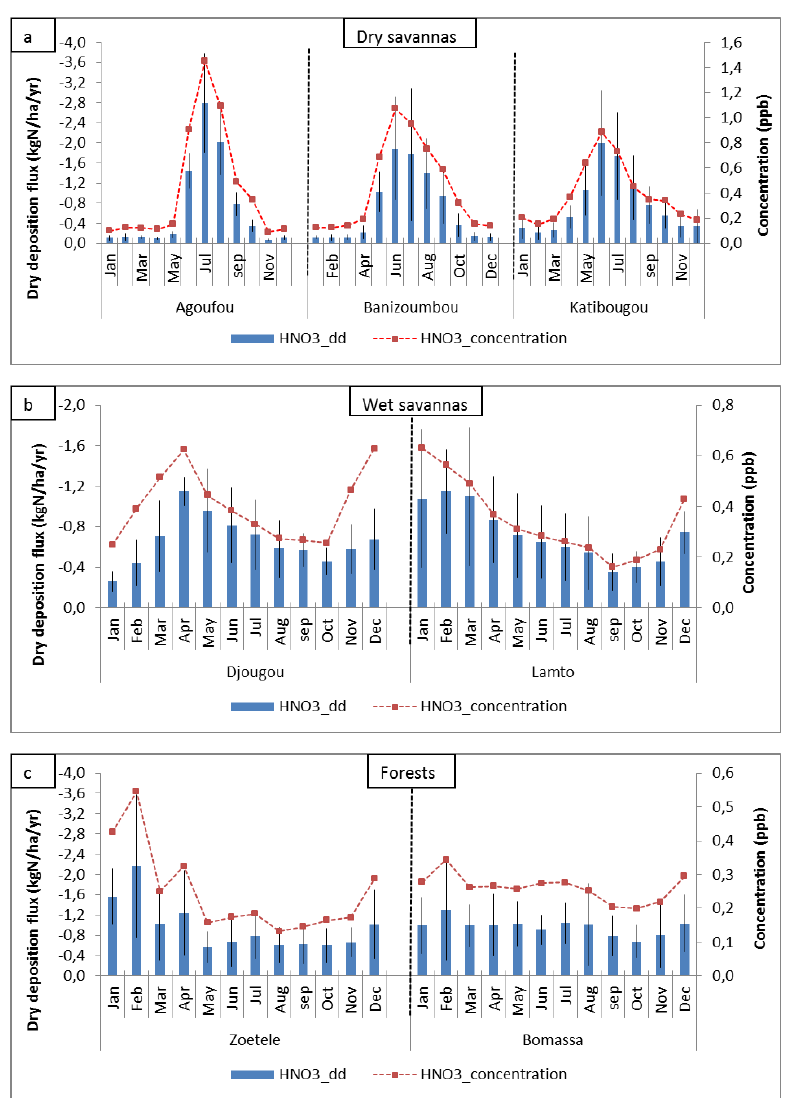
Fig. 6. Evolution of monthly dry deposition fluxes of HNO 3 (HNO 3 _dd) inkgNha − 1 yr − 1 (1998–2007) on the transect dry savannas (a) , wet savannas (b) and forests (c) associated with evolution of HNO 3 concentrations